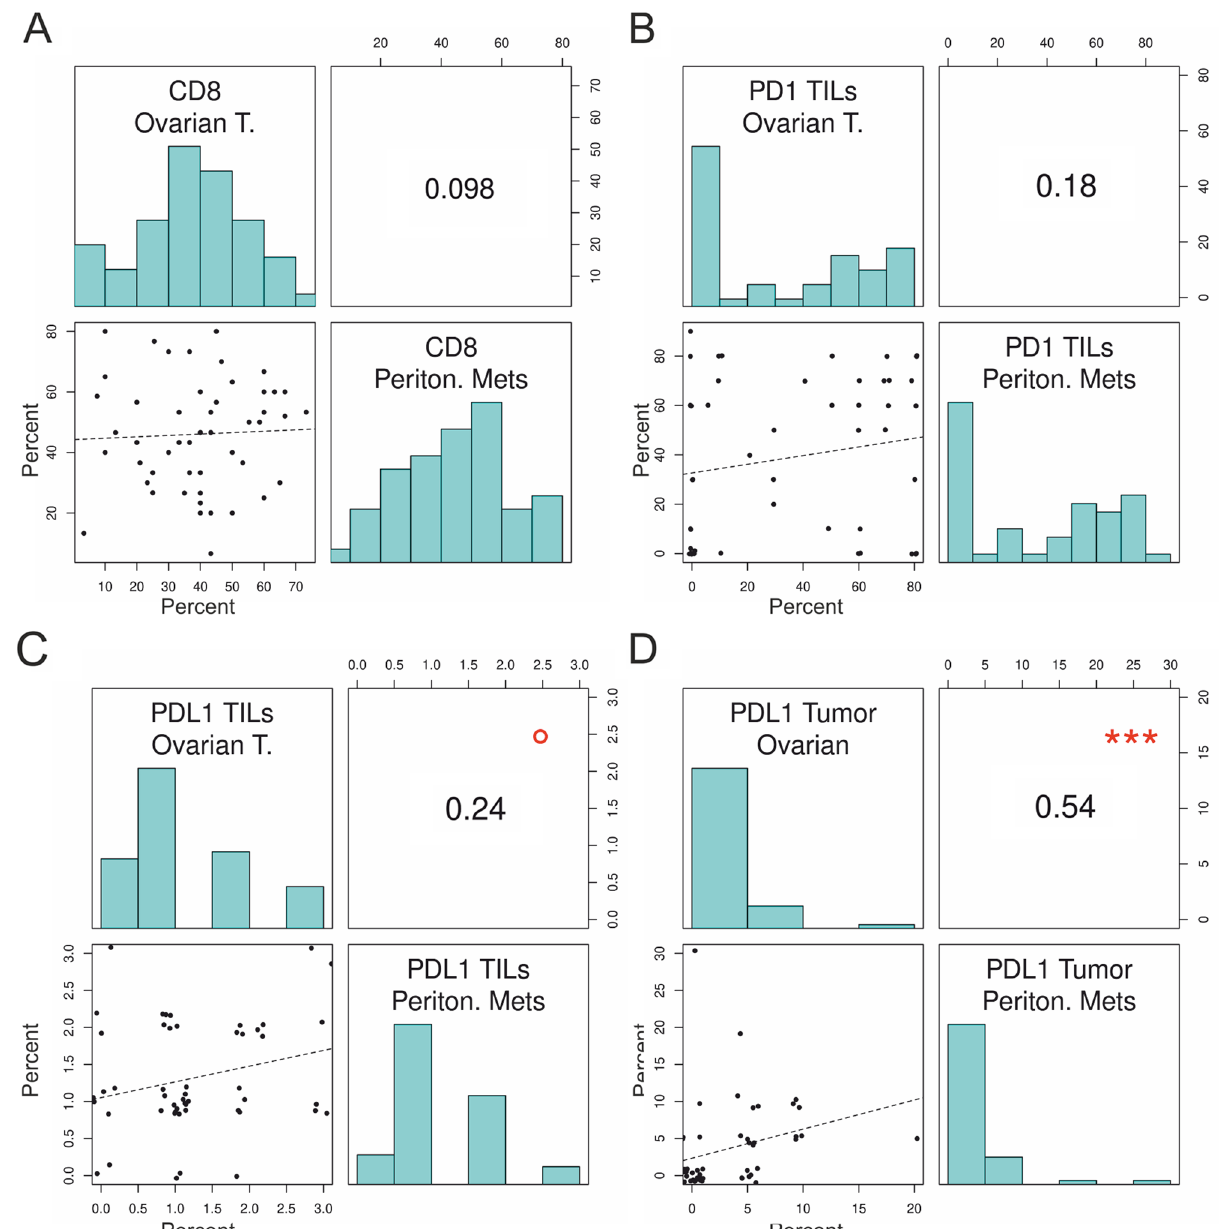
Figure 1. Correlation of CD8 TILs ( A ), PD-1 TILs ( B ), PD-L1 TILs ( C ) and PD-L1 Tumor ( D ) in ovarian tumor tissue with the respective values in peritoneal metastases. °p < 0.1; ***p < 0.001. The top left and bottom right quadrants show histograms of the distribution of percentages. X-axis for the left quadrants is shown at the bottom and for the right side at the top of each panel. For Plots ( B ), ( C ), and ( D ) values were shown around the categorized percentages to see all